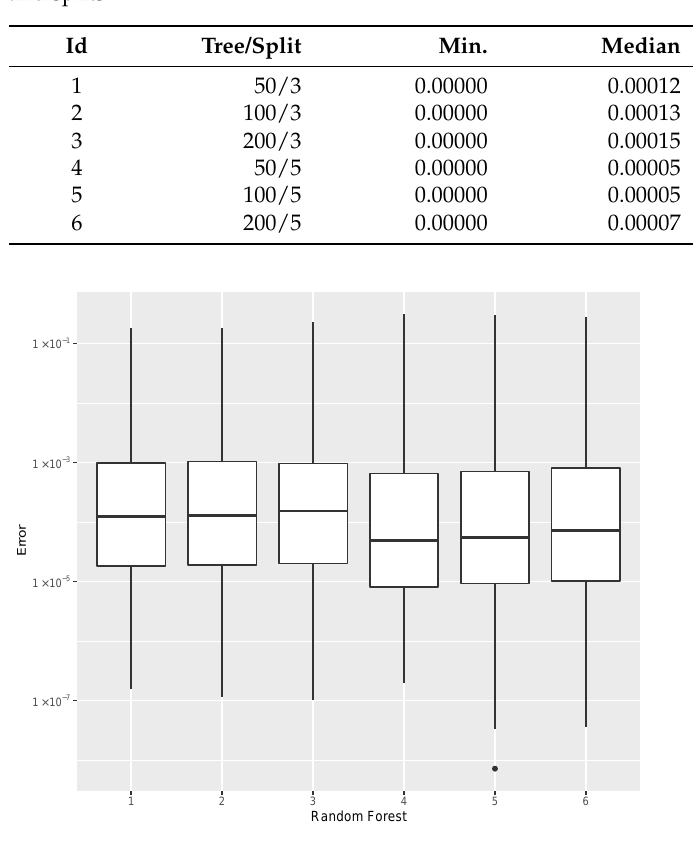
Table 7. Error statistics of the b I meta-model using a Random Forest with distinct number of trees and splits.